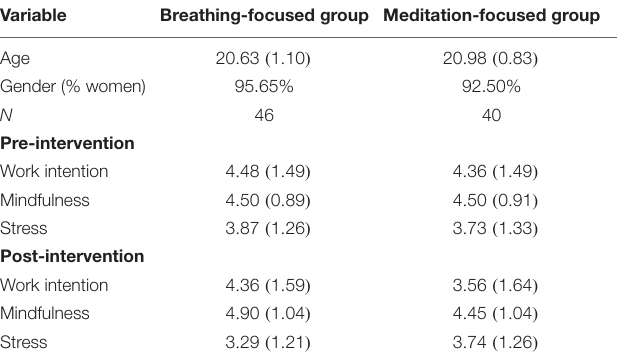
TABLE 2 | Descriptive statistics for each group, mean (SD).